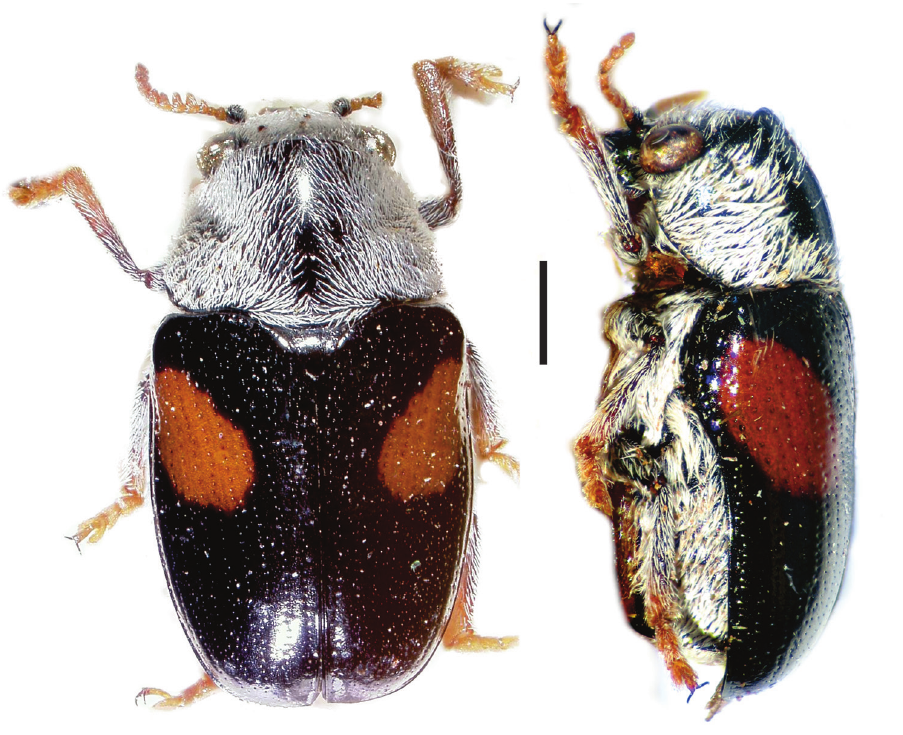
Figure 17. Coscinoptera albopilosa (Monrós) (1) , left: habitus (dorsal view), right: habitus (lateral view). Coscinoptera Lacordaire,